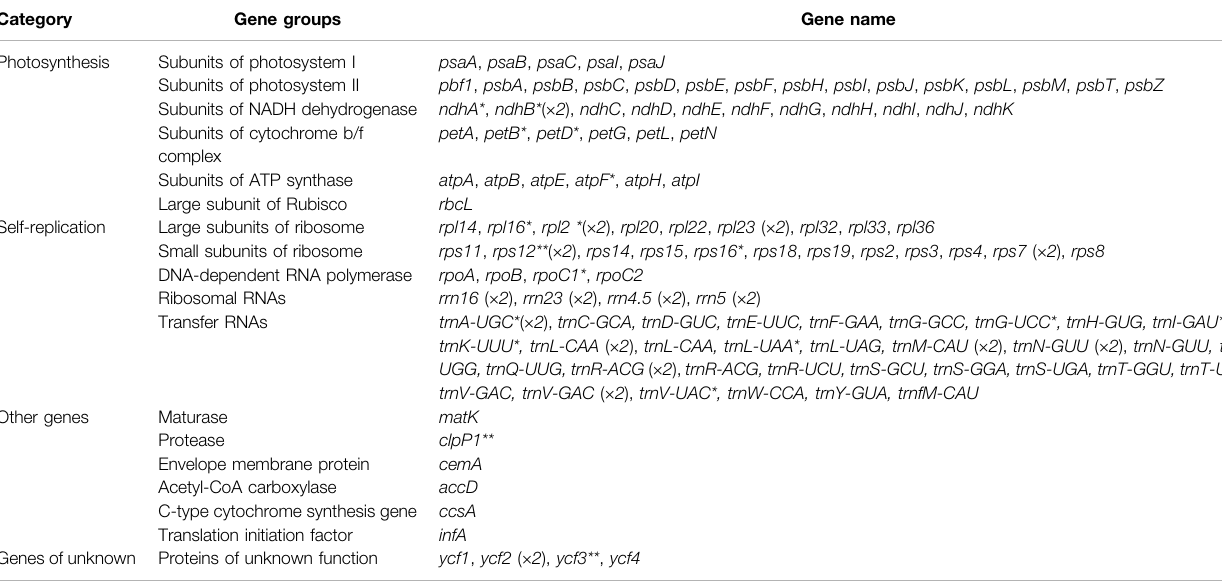
TABLE 2 | Genes encoded in the chloroplast genomes of fi ve Tilia